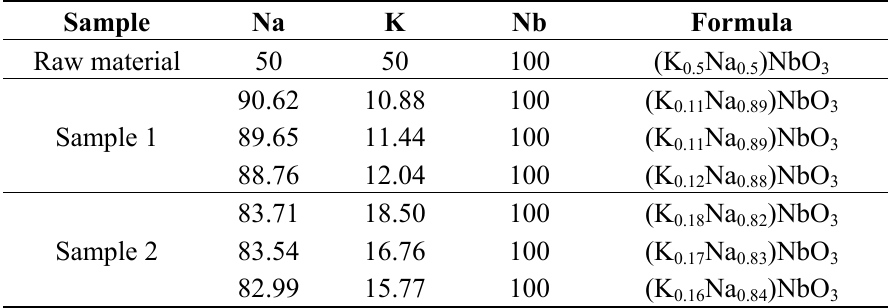
Table 1. Composition calculated the electron probe microanalysis (EPMA) results of the obtained KNN crystals.